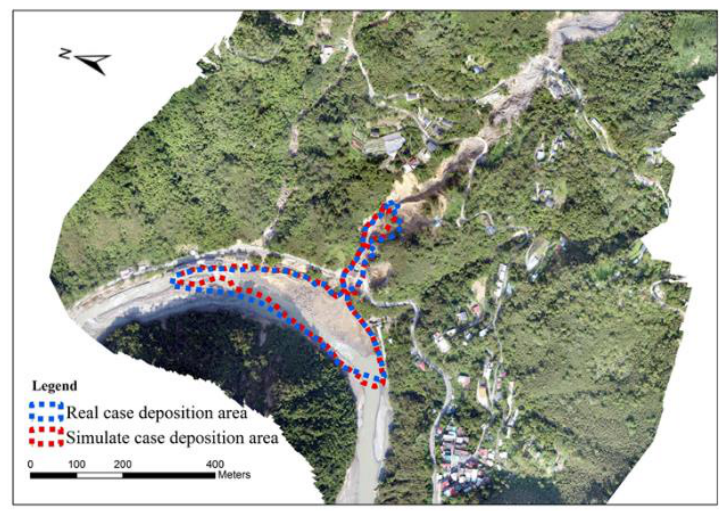
Figure 19. Ranges of deposits onsite and in numerical simulation.